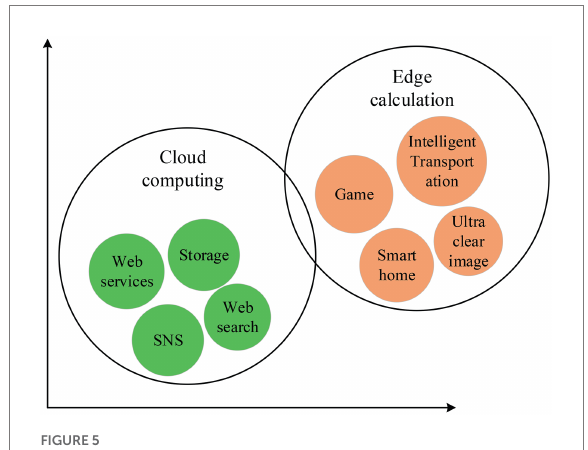
FIGURE 5 Differences between CC and EC.